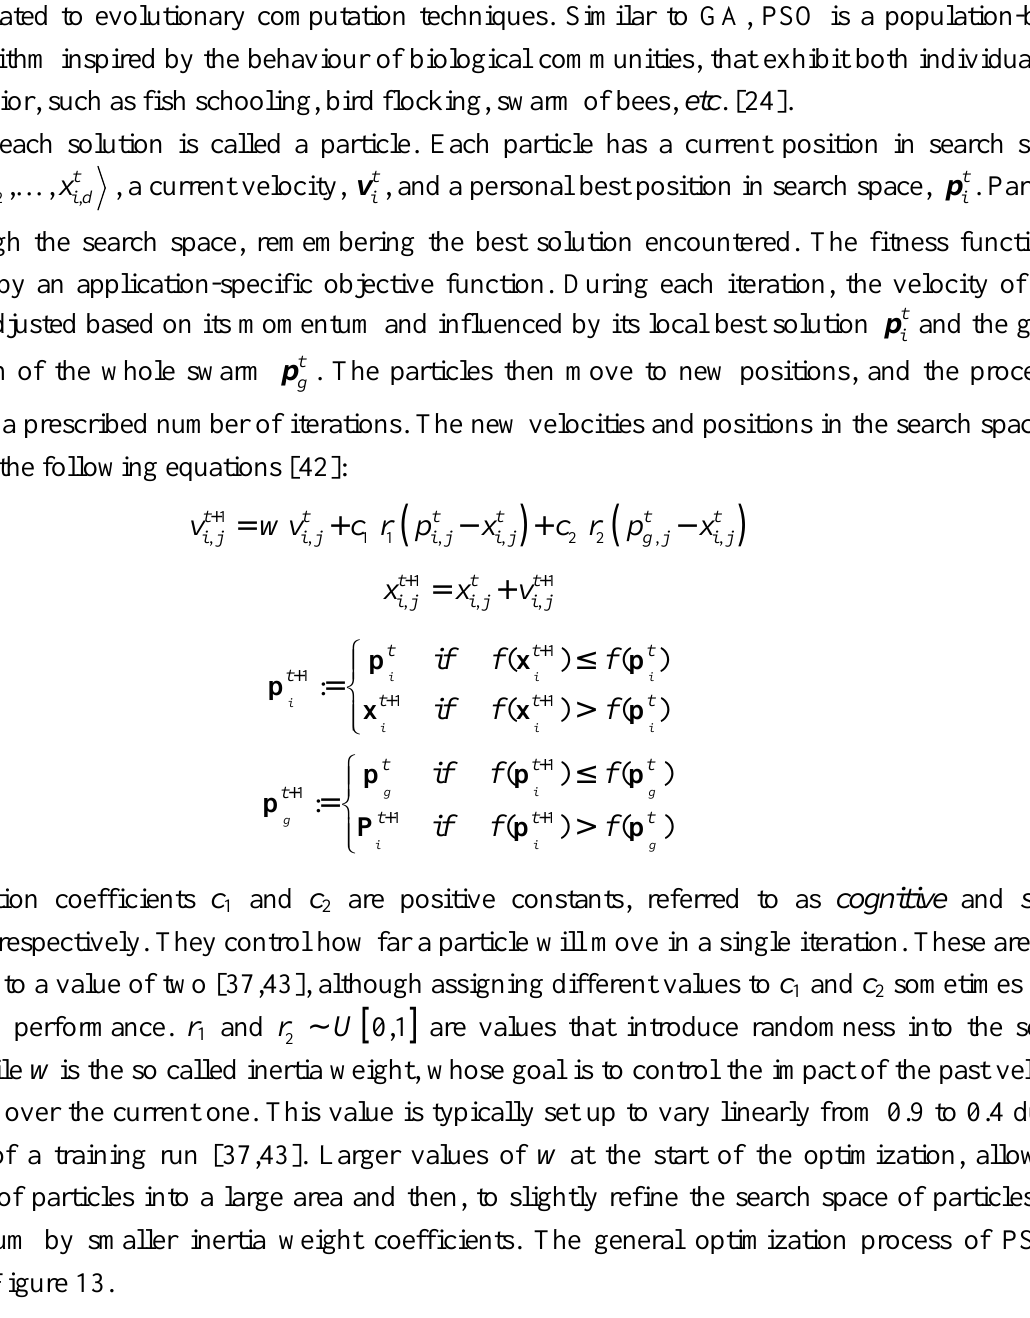
depicted in Figure